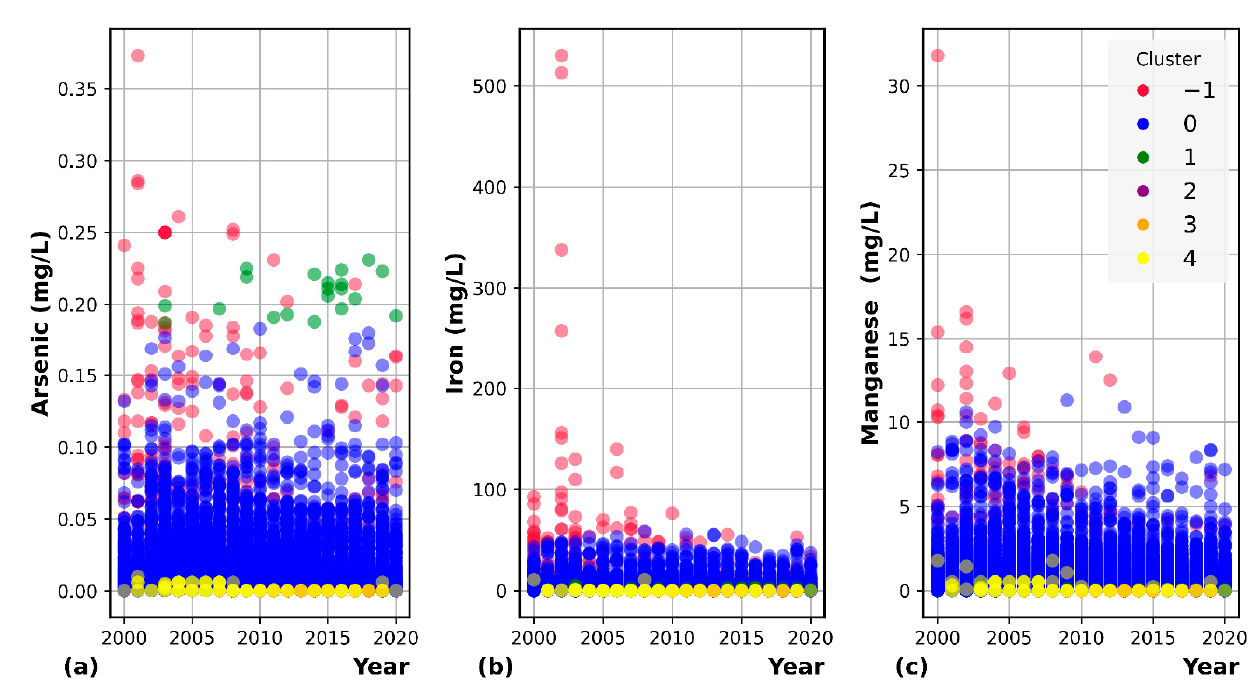
Figure 4. Scatter plot showing the temporal distribution of arsenic ( a ), iron ( b ), and manganese ( c ) in each cluster.